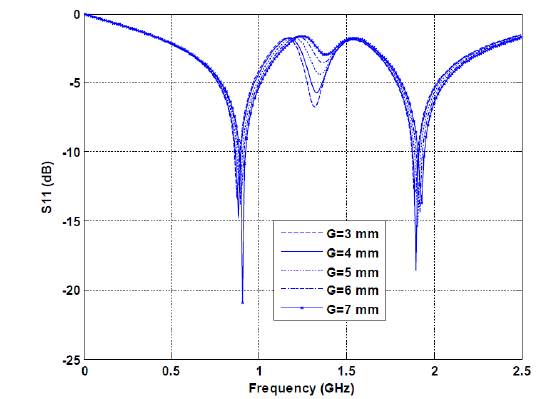
Figure 10: Variation of reflection coeflcient (dB) with frequency on varying gap between fed patch and parasitic patch.